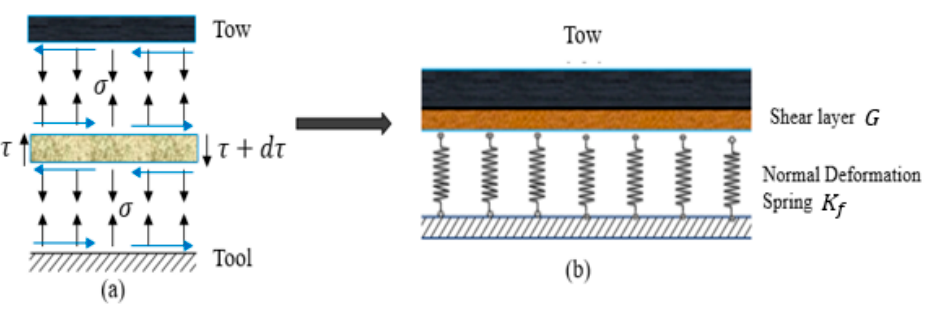
Figure 5. Elastic foundation: ( a ) free body diagram adhesive joint, ( b ) Pasternak elastic foundation model.